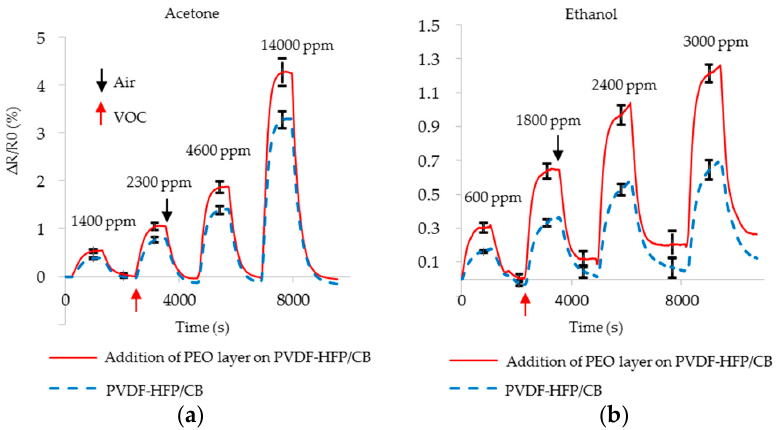
Figure 10. Resistance change of the PVDF-HFP/CB sensors with PEO layer (red solid) and without PEO layer (blue dotted) as they are exposed to various concentration of ( a ) acetone; ( b ) ethanol.